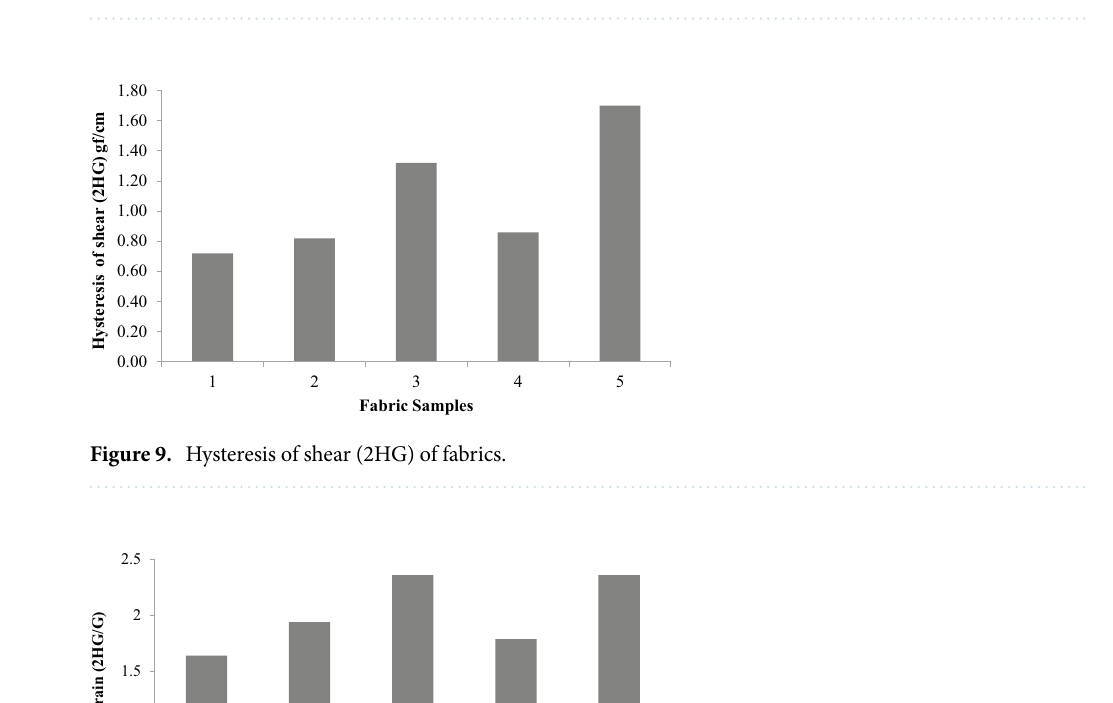
Figure 8. Shear rigidity (G) of fabrics.